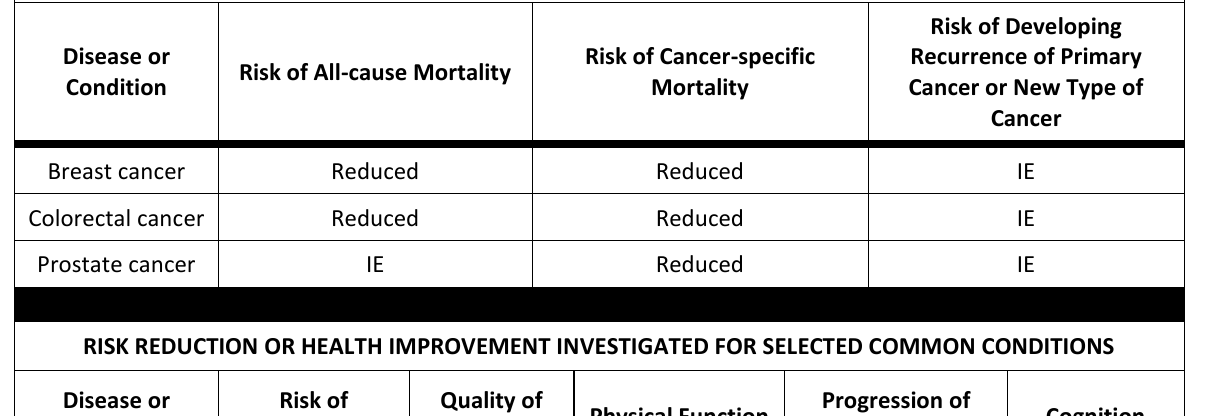
Table D-3. Evidence of Health Benefits from Habitual Physical Activity Among People with One of Several Common Chronic Diseases or Conditions RISK REDUCTION OUTCOMES INVESTIGATED FOR SURVIVORS OF THREE COMMON